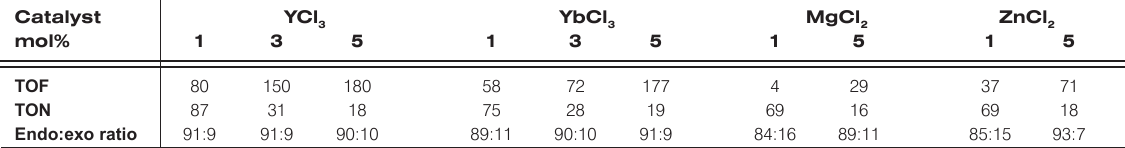
Table 3. TON, TOF and endo:exo ratios dependence on catalyst concentration in the reaction between ethyl acrylate and cyclopentadiene